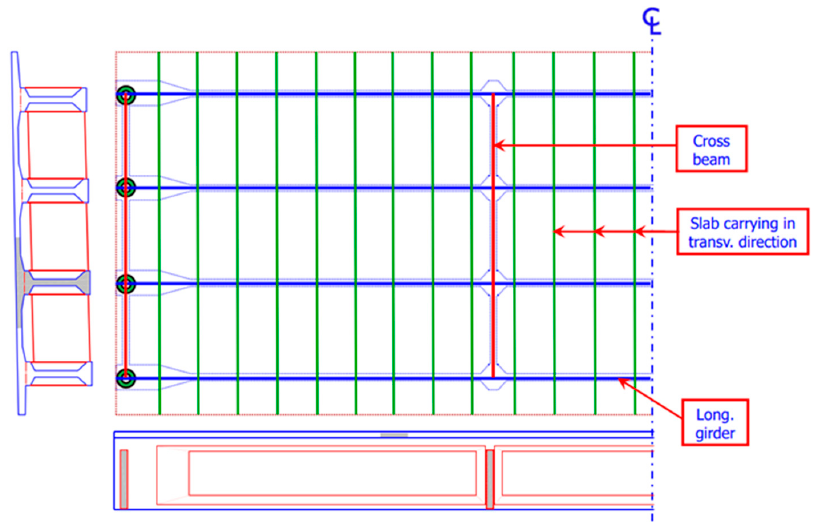
Figure 9. Grid model representation [12].